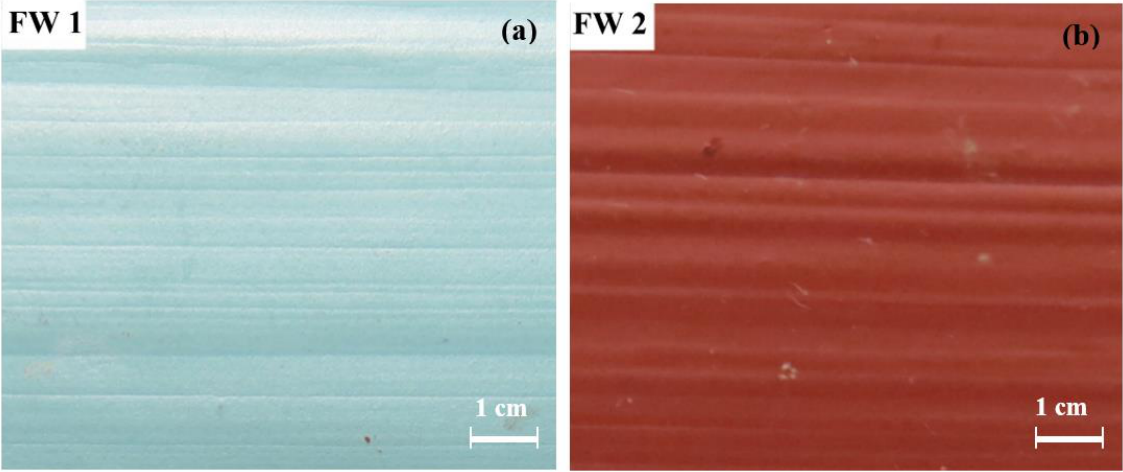
Figure 1. Digital photos of ( a ) FW1 and ( b ) FW2 coating surface after immersion for 600 d.